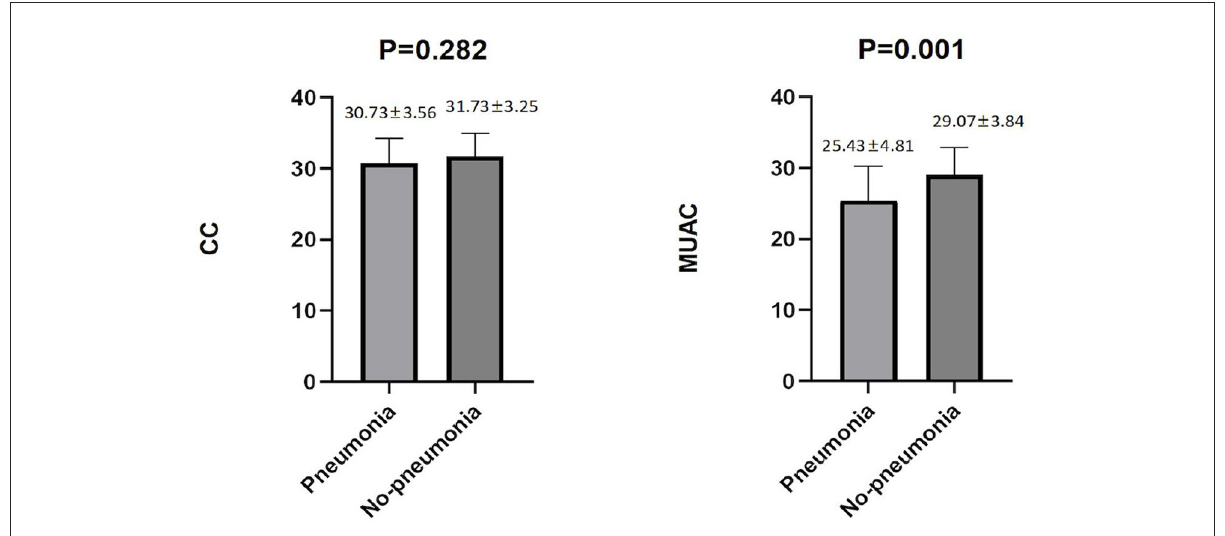
FIGURE3 Differences in CC and MUAC between pneumonia and non-pneumonia in females. The Student’s t -test was employed for comparison of two